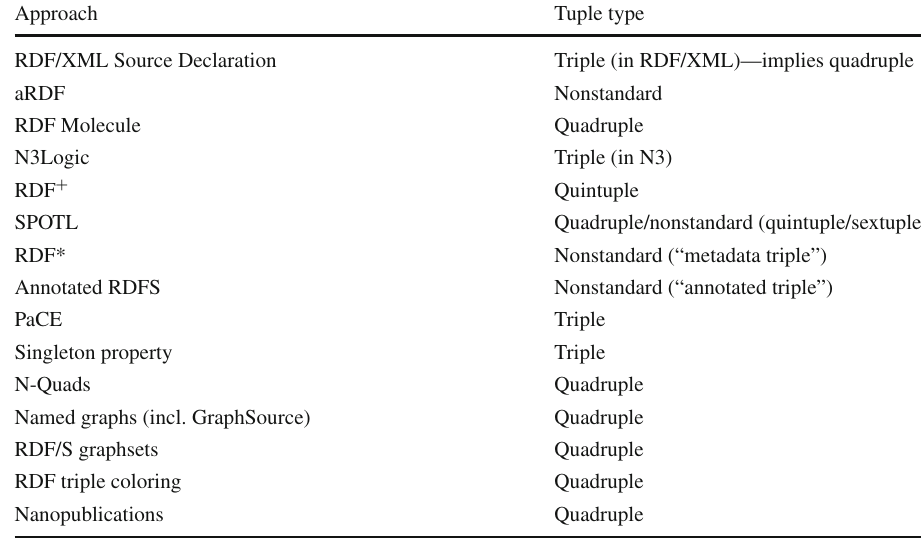
Table 4 Reification alternatives employ 3–6 elements